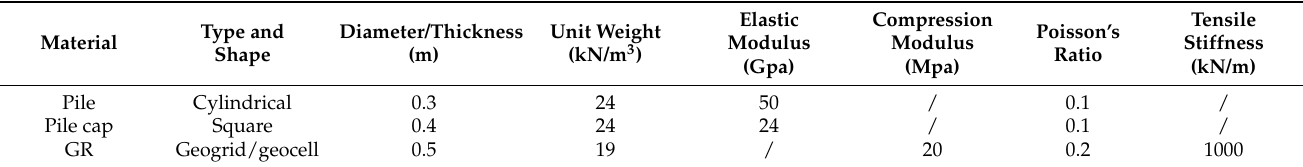
Table 3. Mechanical properties of piles, pile caps, and